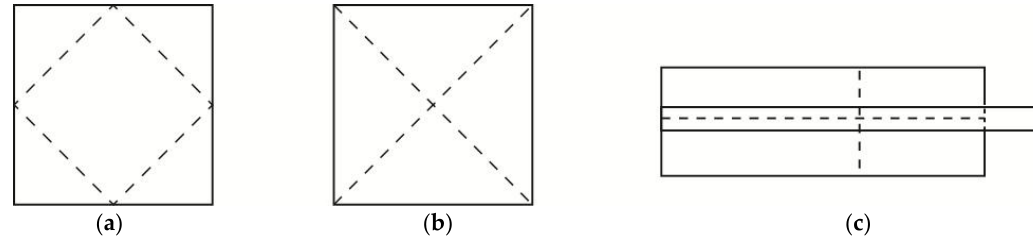
Figure 1. Multifolding. ( a ) Non-overlapping folding lines; ( b ) Overlapping folding lines, and ( c ) combination of overlapping and non-overlapping folding lines.